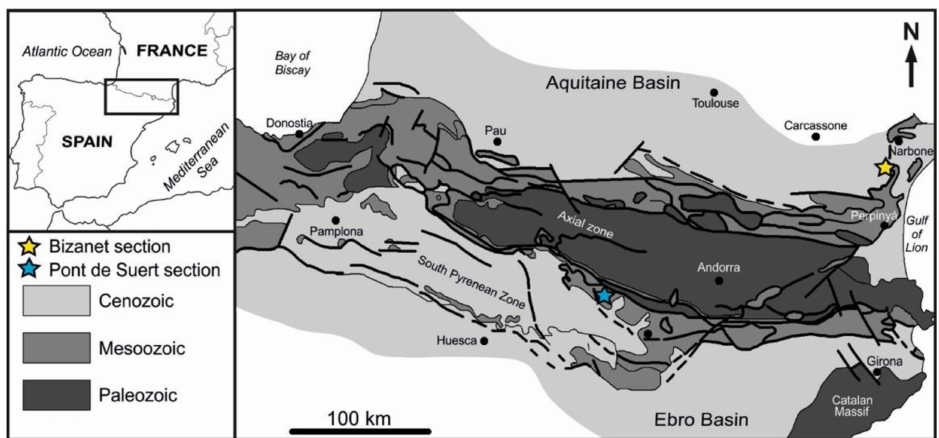
Figure 1. Simplified geological map of the Pyrenean Basin and location of the studied Bizanet section (adapted with permission from ref. [32]. Copyright 2018 Elsevier).